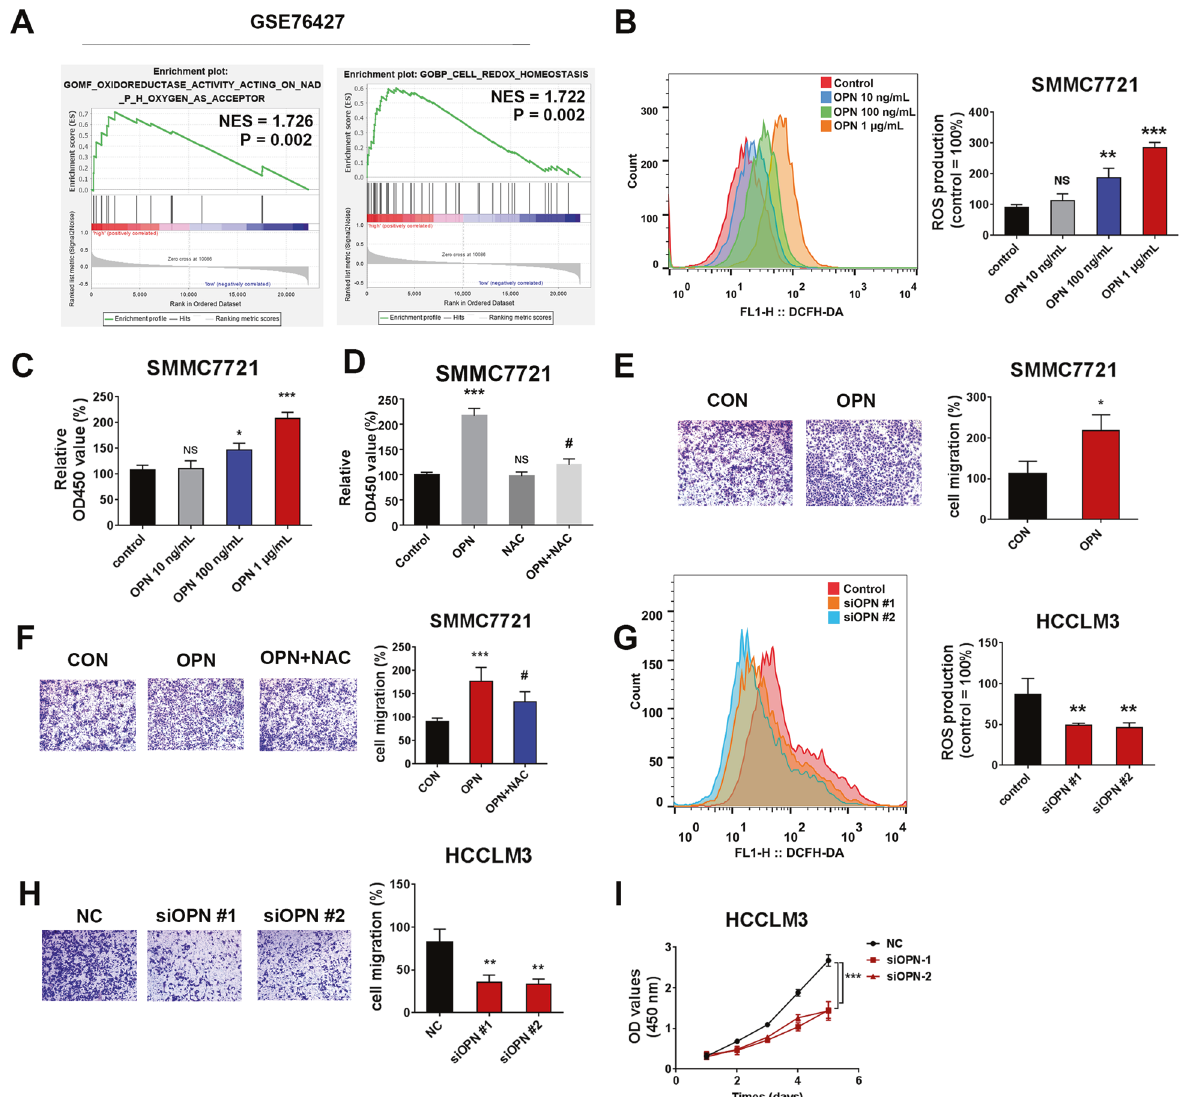
Fig. 1 OPN-induced ROS production promotes the cell proliferation and migration of HCC cells. The results of oxidoreductase activity and cell redox homeostasis in the tumor tissues of HCC patients (data from GEO data-set GSE76427) ( n = 115) ( A ). The level of ROS in SMMC7721 cells after treatment with different concentrations of OPN recombinant protein (10 ng/mL, 100 ng/mL, 1 μ g/mL) ( B ). CCK8 and transwell assays were performed to detect the viability and migration of SMMC7721 cells ( C , E ). The effects on cell viability and migration were analyzed in hOPN treated SMMC7721 cells after treating them with NAC (5 mM) for 2 h ( D , F ). The level of ROS in HCCLM3 cells, 72 h after infecting them with siOPN ( G ). The transwell assay and growth curve were performed to detect the proliferation and migration of HCCLM3 cells ( H , I ). Original magni fi cation, ×100 (scale bars: 100 μ m). Data indicated mean ± SD. n = 3, * P < 0.05, ** P < 0.01, *** P < 0.001, # Compared with hOPN